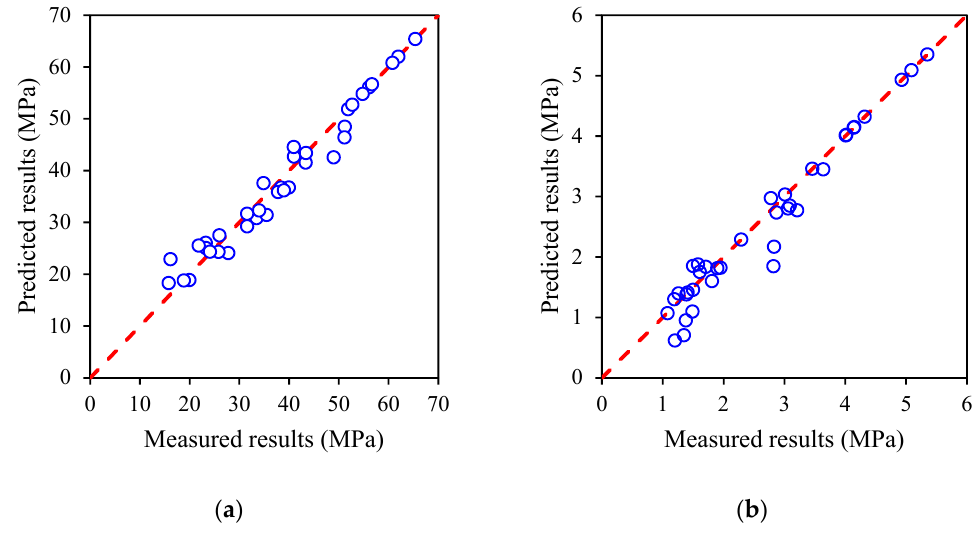
Figure 14. Comparison between experimental data and predicted results using proposed models for: ( a ) compressive strength with parameter s 1 ; ( b ) splitting tensile strength with parameter s 2